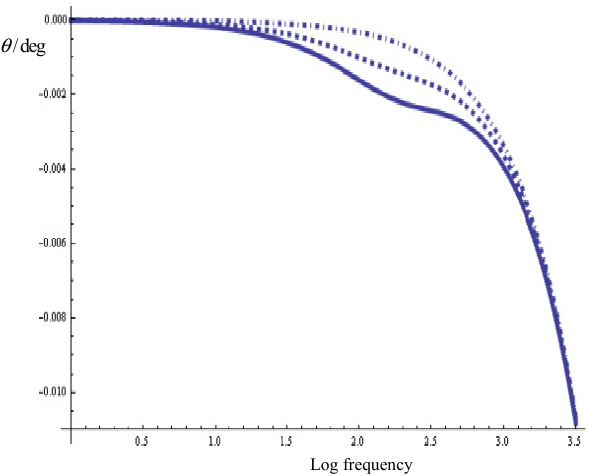
Fig. 1C: Phase Spectra: Δϕ 0 =-150 mV (solid), Δϕ 0 =-75mV(dashed), Δϕ 0 ~0V(dot-dashed line) When considering suspensions of larger cells ( R 1 ~ 0.5 mm), impedance variation significantly enhances, but